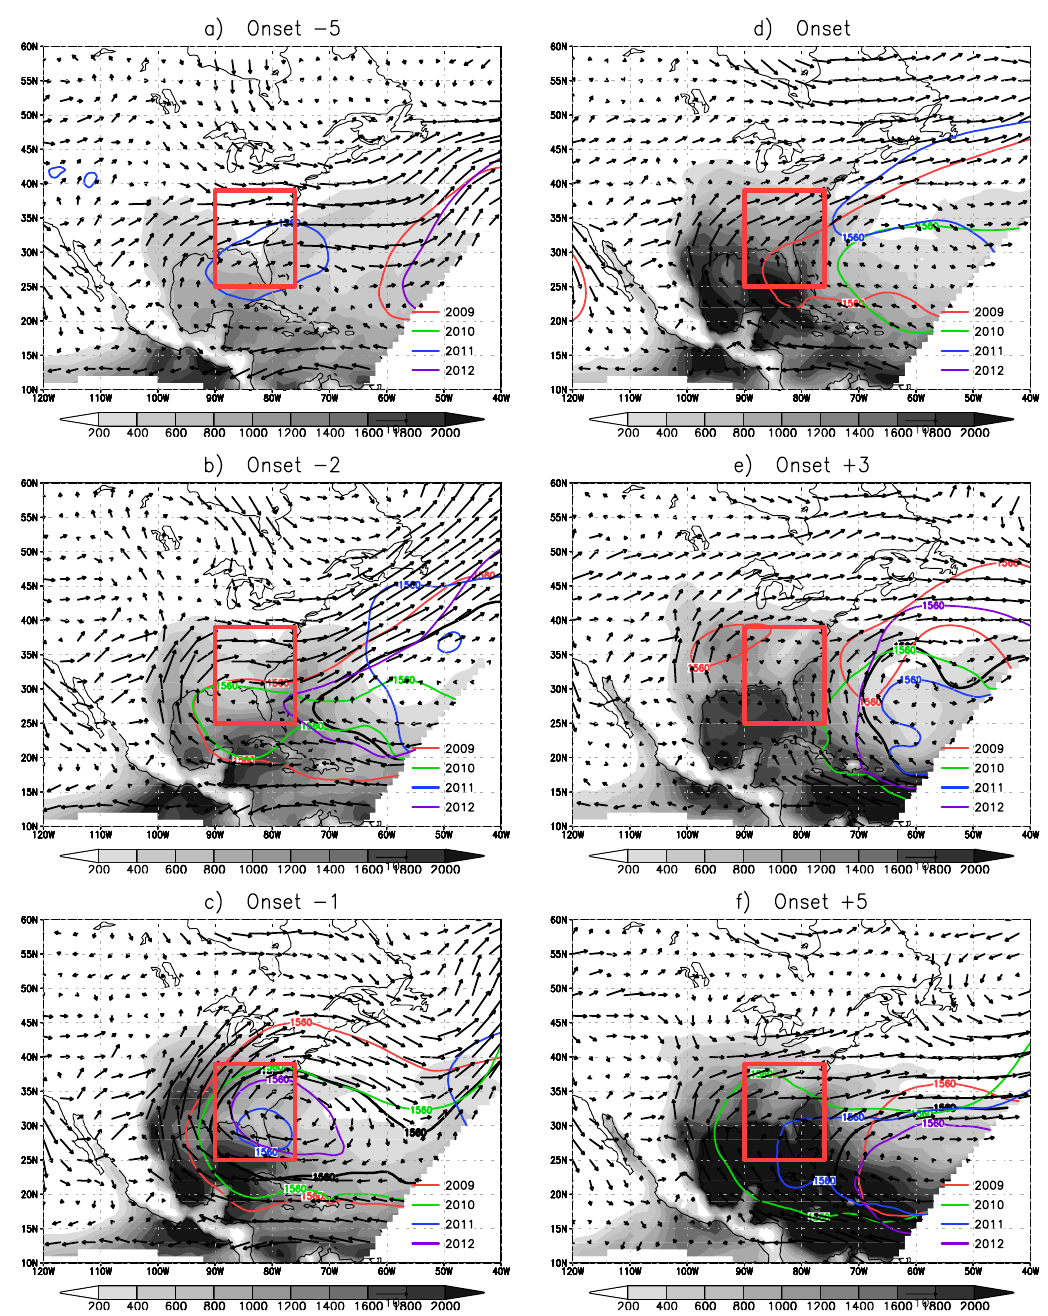
Figure 3. Pentad composites for the four-year period of CAPE (J Kg − 1 , shaded starting at 200 J Kg − 1 for every 200 J Kg − 1 ) and 850 hPa winds (m s − 1 ) at the ( a ) onset − 5, ( b ) onset − 3, ( c ) onset − 1, ( d ) onset, ( e ) onset +3, and ( f ) onset +5 pentads. The composite 1560 m geopotential contours (m) are shown for each year (2009 in red, 2010 in green, 2011 in blue, and 2012 in purple) and for the four-year mean (black contours). Red box marks the SE US domain.